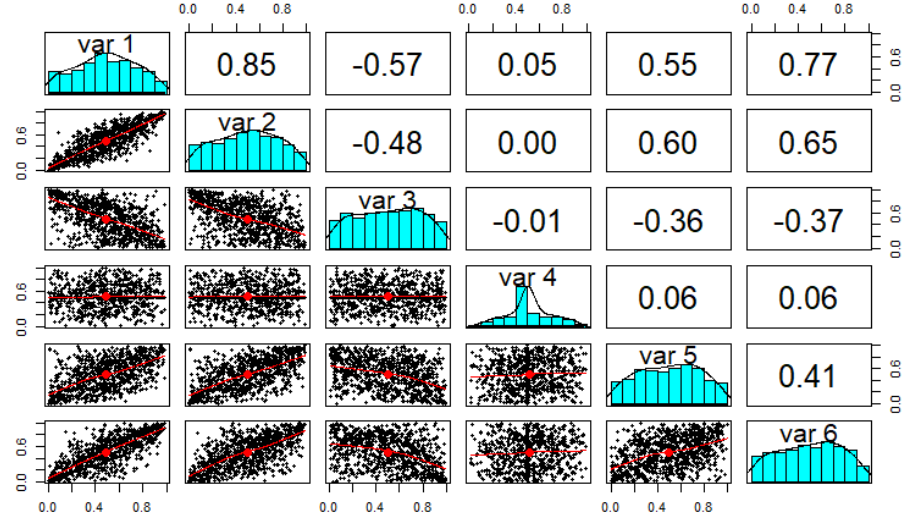
Figure 5. Scatterplots between pseudo-observations of each pair of indexes in the lower triangular panels, histograms of each marginal in the diagonal, and Pearson’s correlation coefficients in the upper triangular